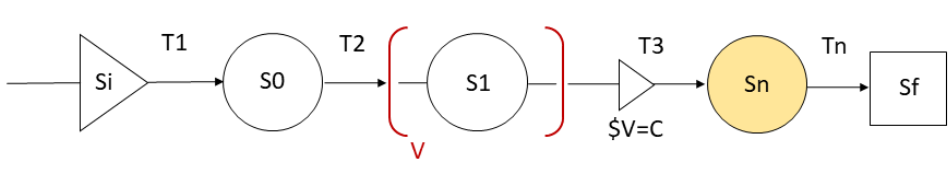
Figure 1. Example of a Nooj Finite State